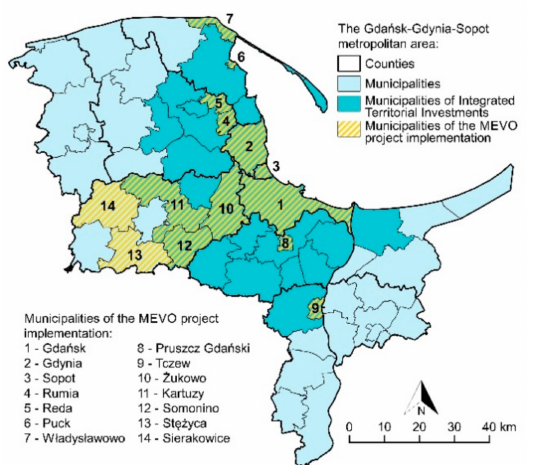
Figure 1. Administrative division of the Metropolitan Area Gda´nsk–Gdynia–Sopot (MAGGS) and the range of the metropolitan public bike system project. Source: Author’s own